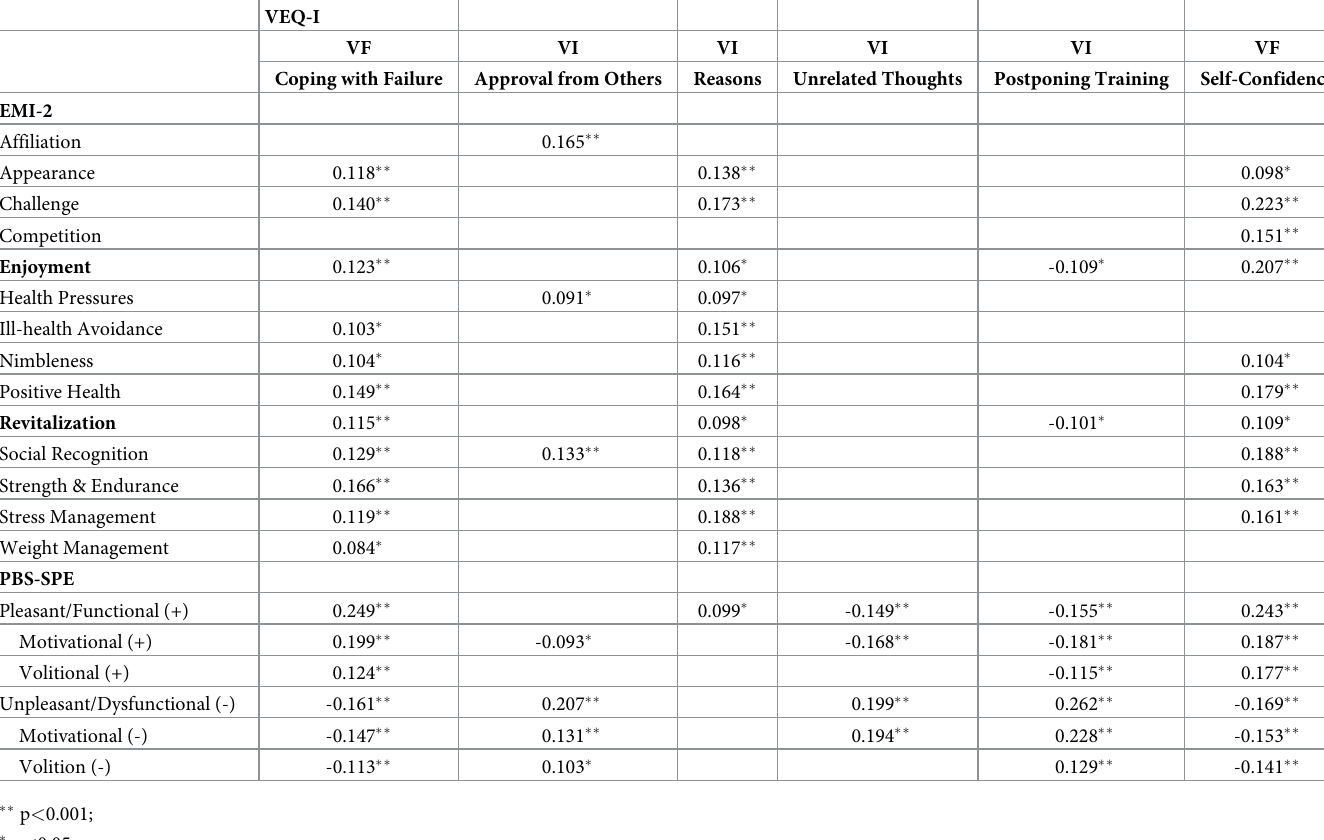
Table 3. Pearson’s